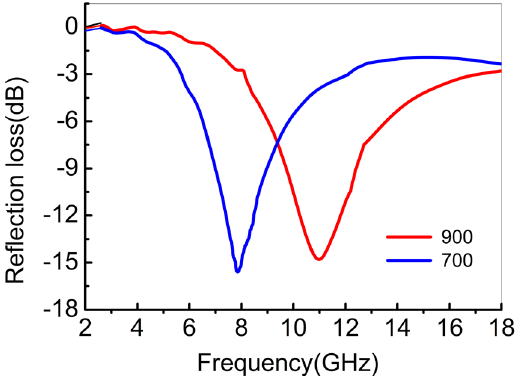
Figure 9. The experimental reflectivity curve of 3-mm-thick CNT composite coatings with a CNT content of 15 wt.%. The composites were heat-treated for 3 h at temperatures of 700 °C and 900